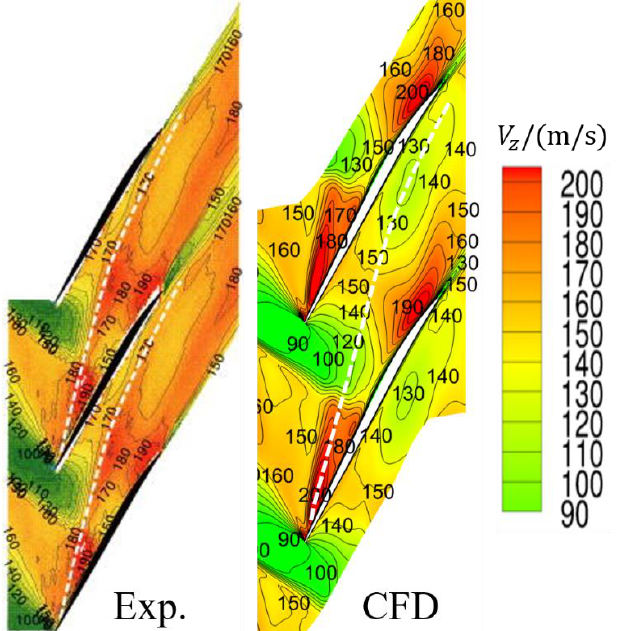
Figure 6. Comparison between numerical and experimental axial velocity contours at 92% rotor span at the PEP at 80% design speed.